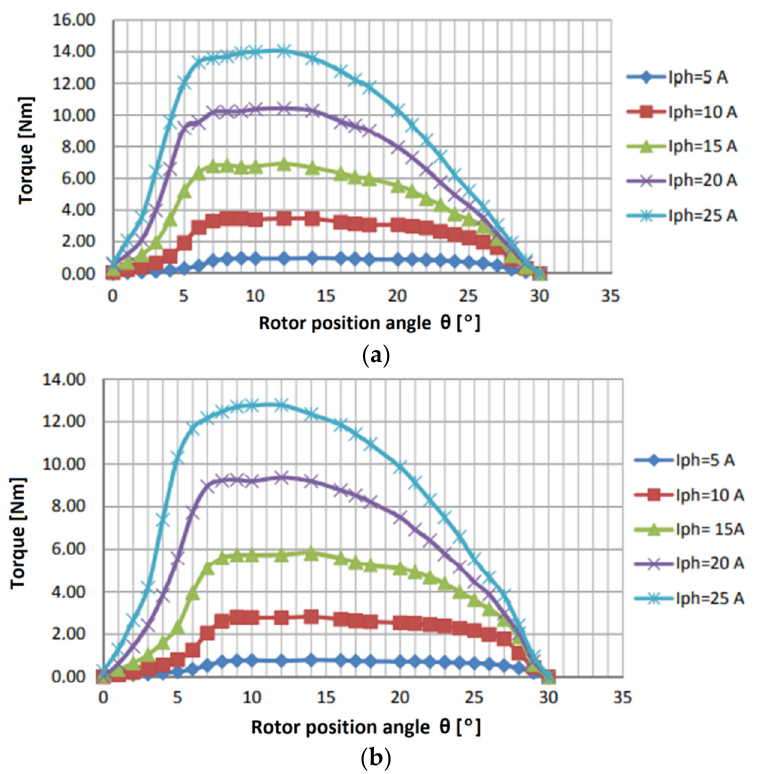
Figure 8. The appearance of the tested 8/6 symmetrical switched reluctance motors rotors: ( a ) straight poles; ( b ) oblique poles.